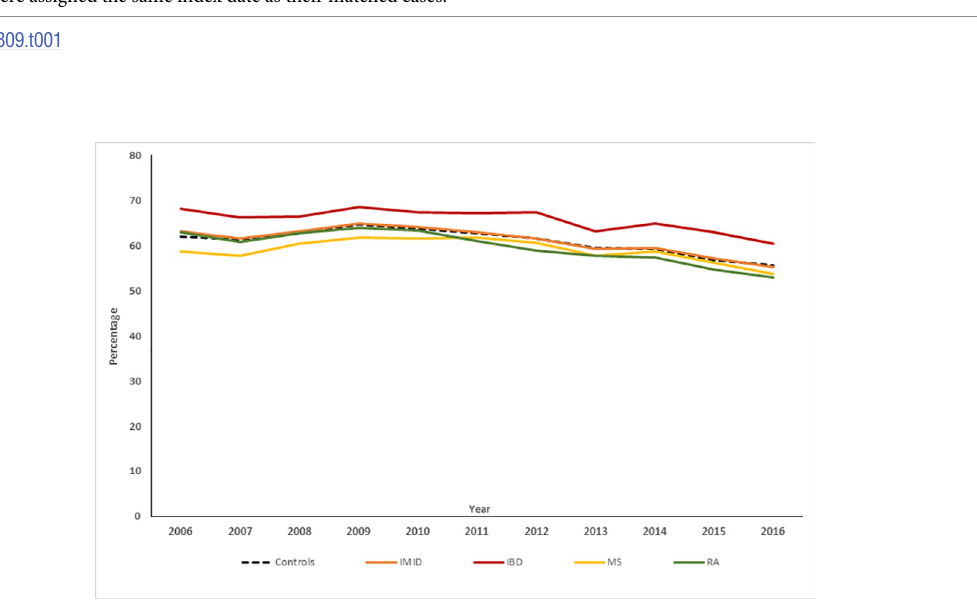
Fig 1. Mammography participation rates for 2006–2016 age-standardized to 2010